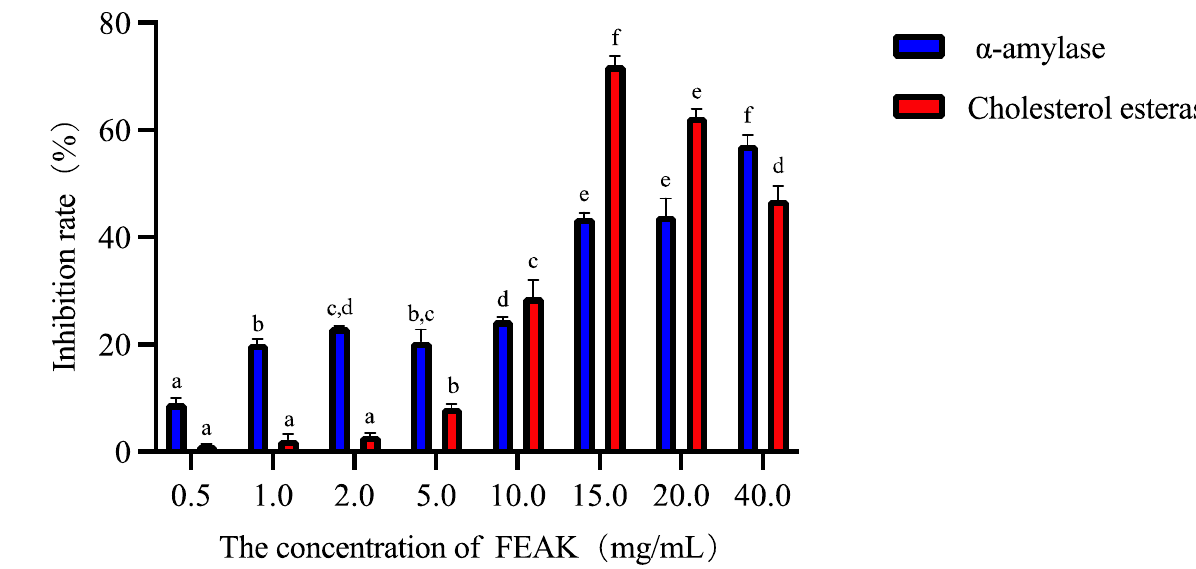
Figure 1. The inhibitory rate of the FEAK on the activity of α-amylase and cholesterol esterase. Note: different lowercase letters in the same enzyme activity test group represent the existence of significant differences at p < 0.05 in the different concentration group of the FEAK.